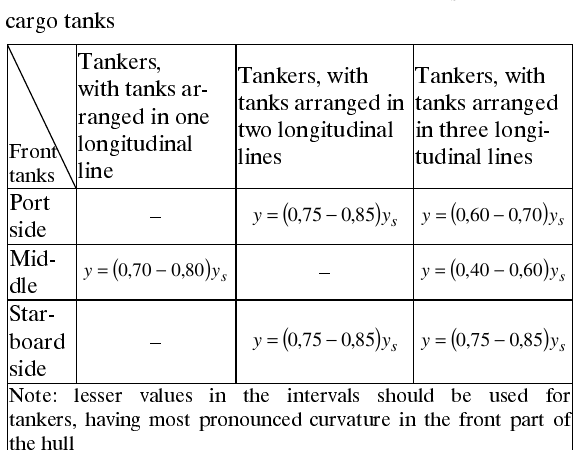
Table 2. Estimation of parameter